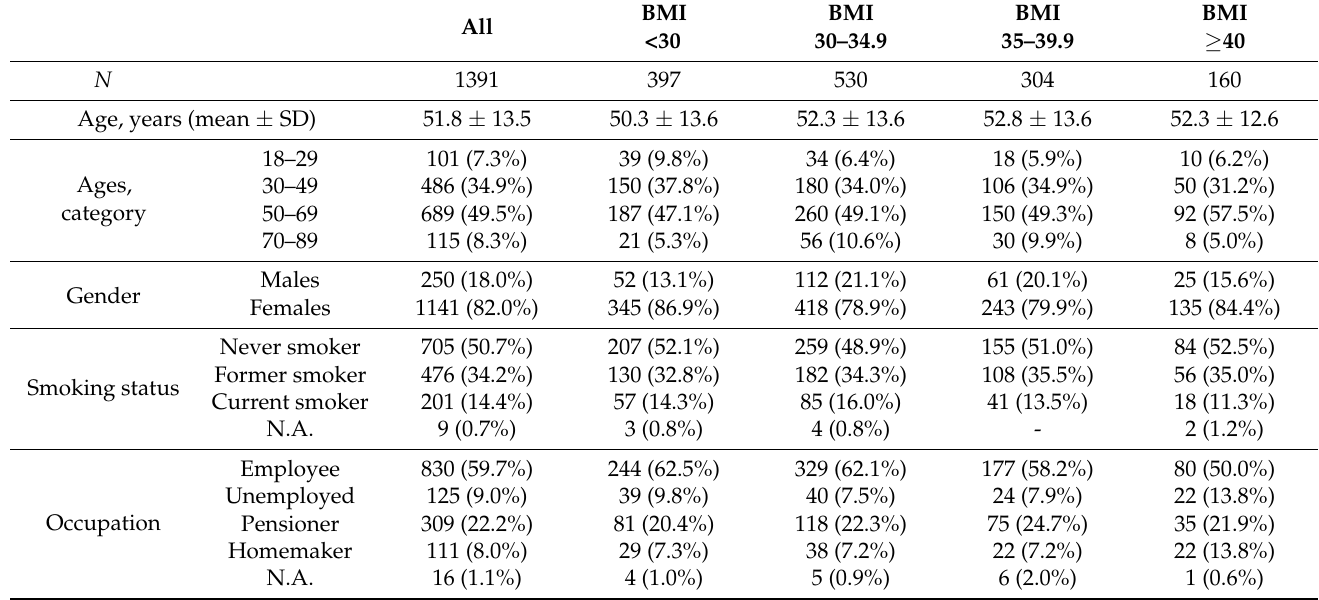
Table 1. Demographic and personal characteristics of the studied